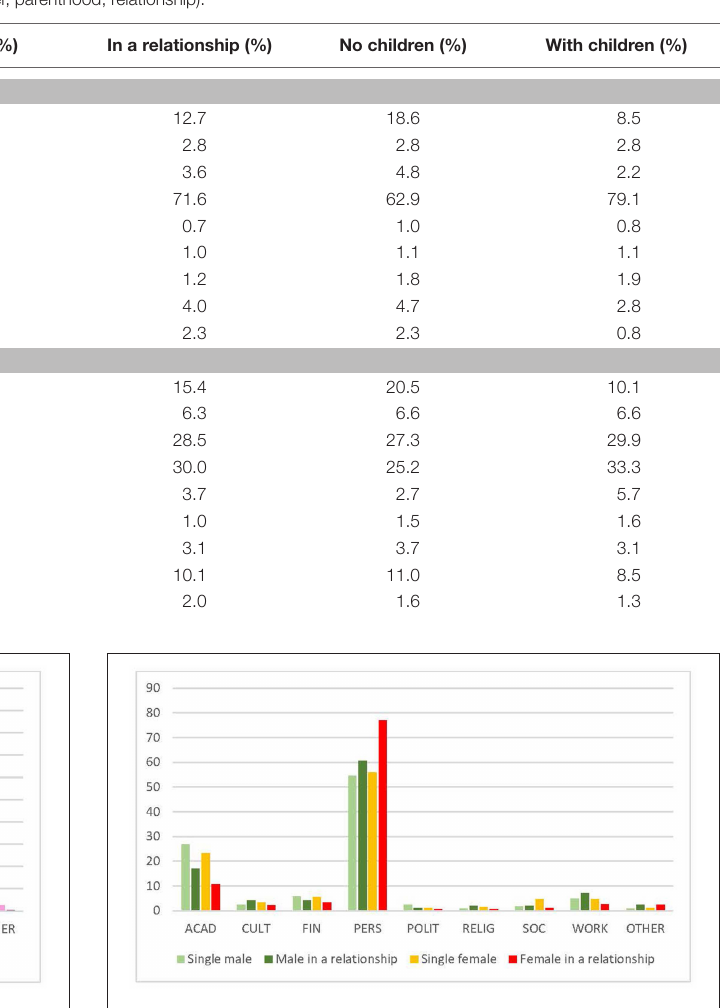
[ χ 2 = 68.3, p < 0.001], and with and without relationship [ χ 2 = 85.0, p <